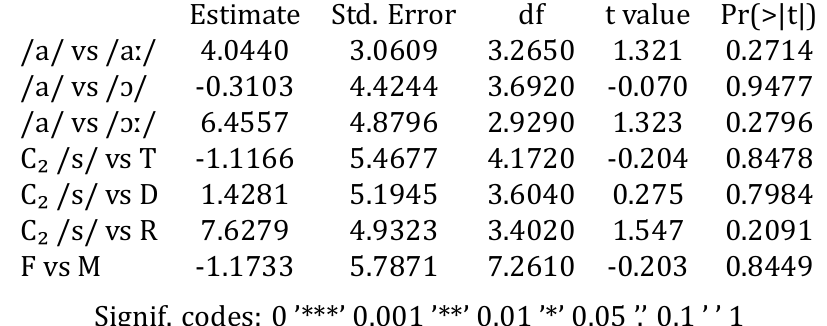
and word, as well as by-speaker random slopes for the effect of C₁ type.